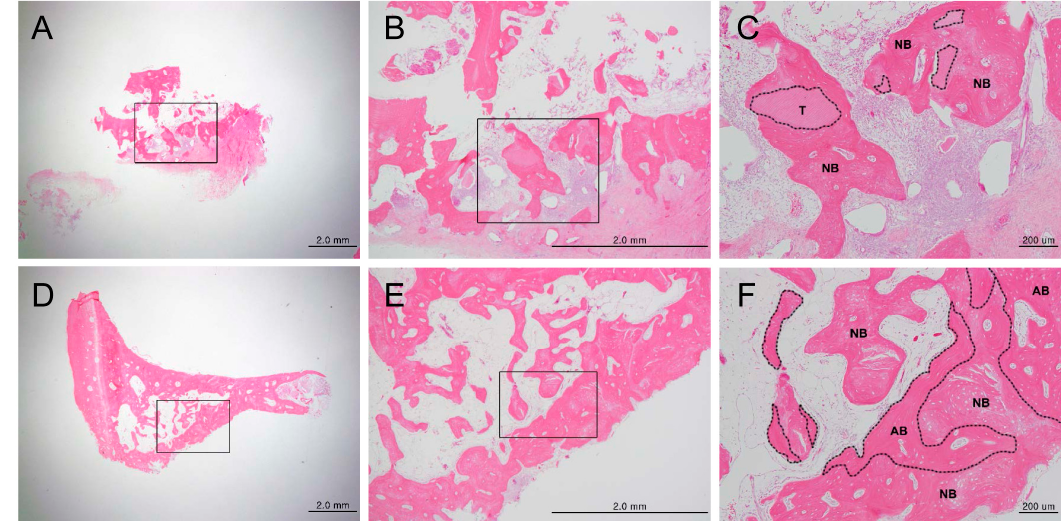
Figure 4. Histological analysis of new bone formation at the bone defect area after eight weeks, by hematoxylin/eosin staining (magnification: ( A , D ) 12.5×; ( B , E ) 40×; ( C , F ) 100×). ( A – C ) Experimental group (DDM fixed with rhBMP-2); ( D – F ) Control group (autogenous bone graft). Figures ( B ) and ( E ) are higher magnification views of figures ( A ) and ( D ), respectively. Figures ( C ) and ( F ) are higher magnification views of figures ( B ) and ( E ), respectively. ( C ) The area enclosed within the dotted line represents DDM fixed with rhBMP-2, and newly-formed bone seen around the DDM. ( F ) The area within the dotted line indicates the autogenous bone graft, and newly-formed bone found around the autogenous bone graft. Scale bars: 2.0 mm ( A , B , D , E ), 200 μ m ( D , F ). T: DDM fixed with rhBMP-2, NB: new bone, AB: autogenous bone .